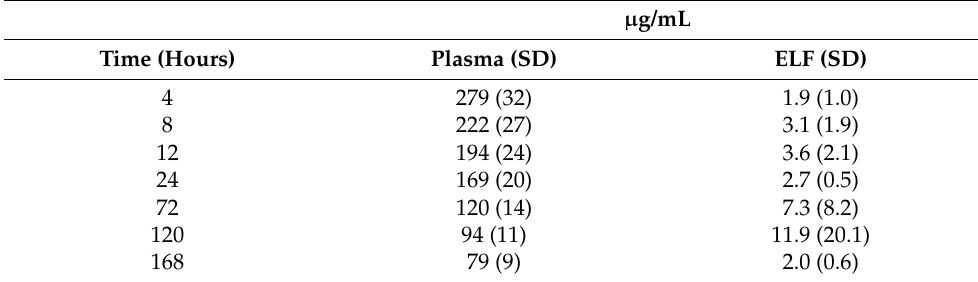
Table 6. Dalbavancin concentration after a single 1500 mg administration [50]. SD—standard